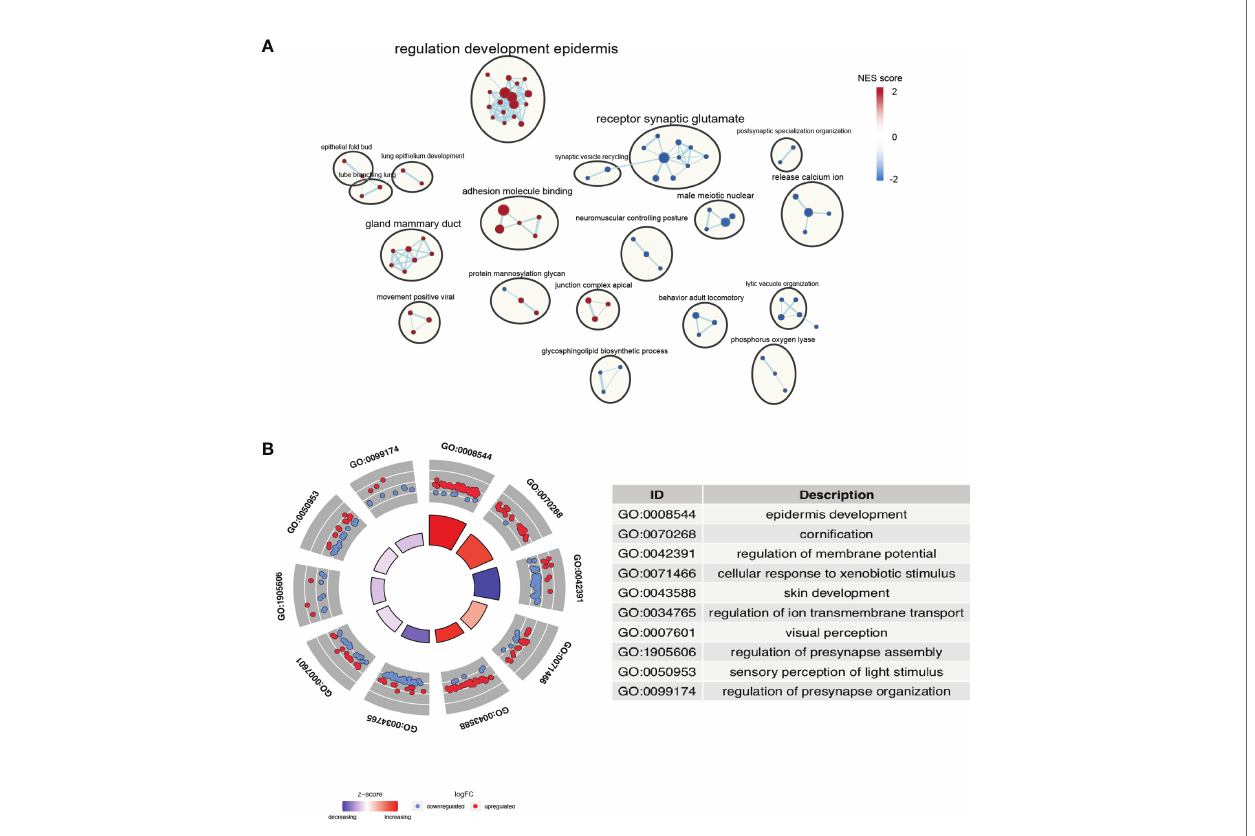
FIGURE 5 | Identi fi cation of the pathways enriched of the high- and low- risk group. (A) Gene set enrichment analysis (GSEA) delineates KEGG pathways that characterize PAAD patients with high risk. (B) Enriched terms are colored by normalized enrichment score (NES), where nodes that share the same cluster ID are typically close to each other based on